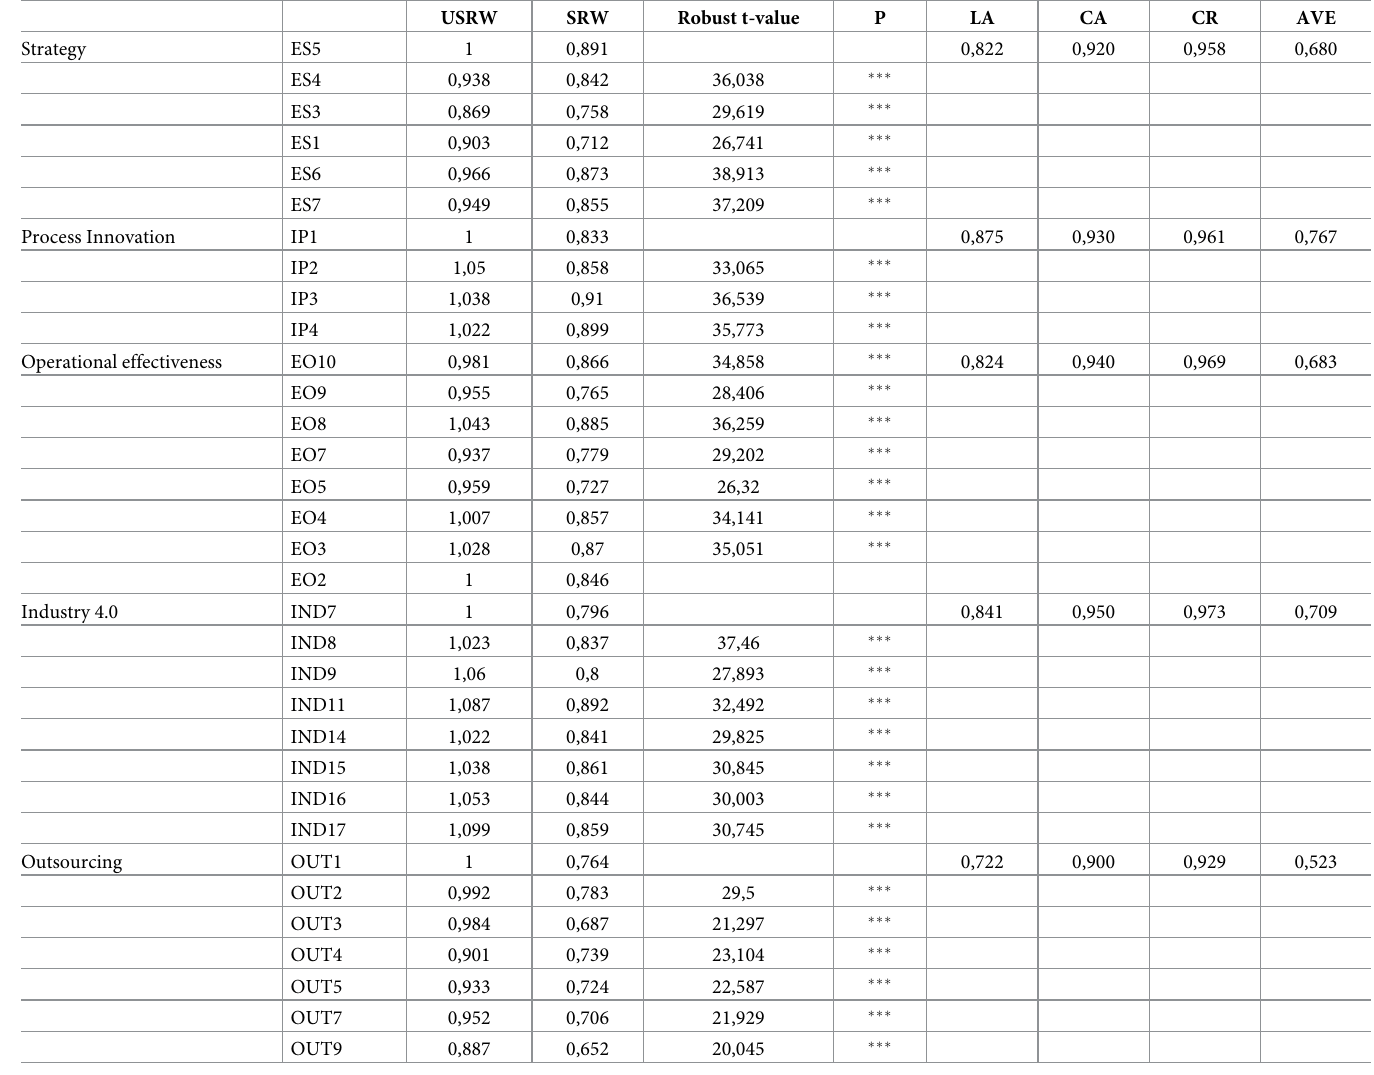
Table 1. Validation of the final measurement model.